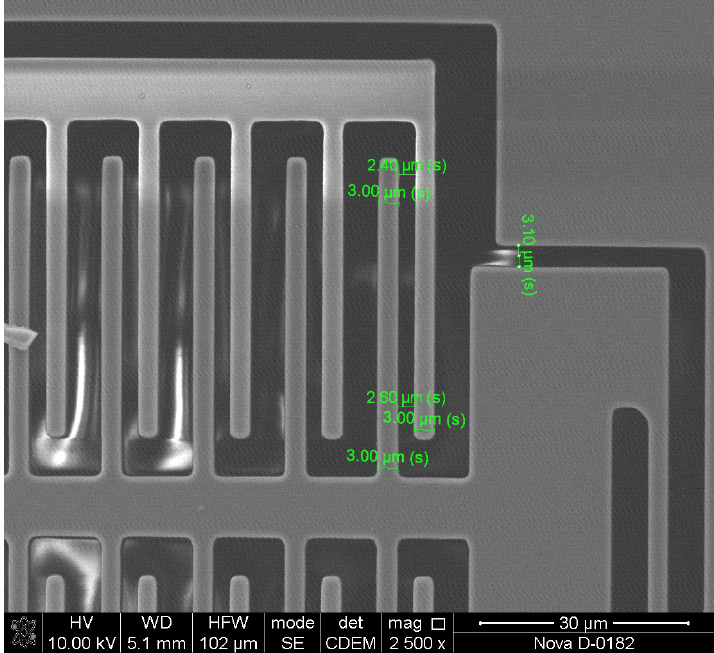
Figure 31. Measurement of the topology of a capacitive converter by SEM. Table 9. The results of topological measurements of the